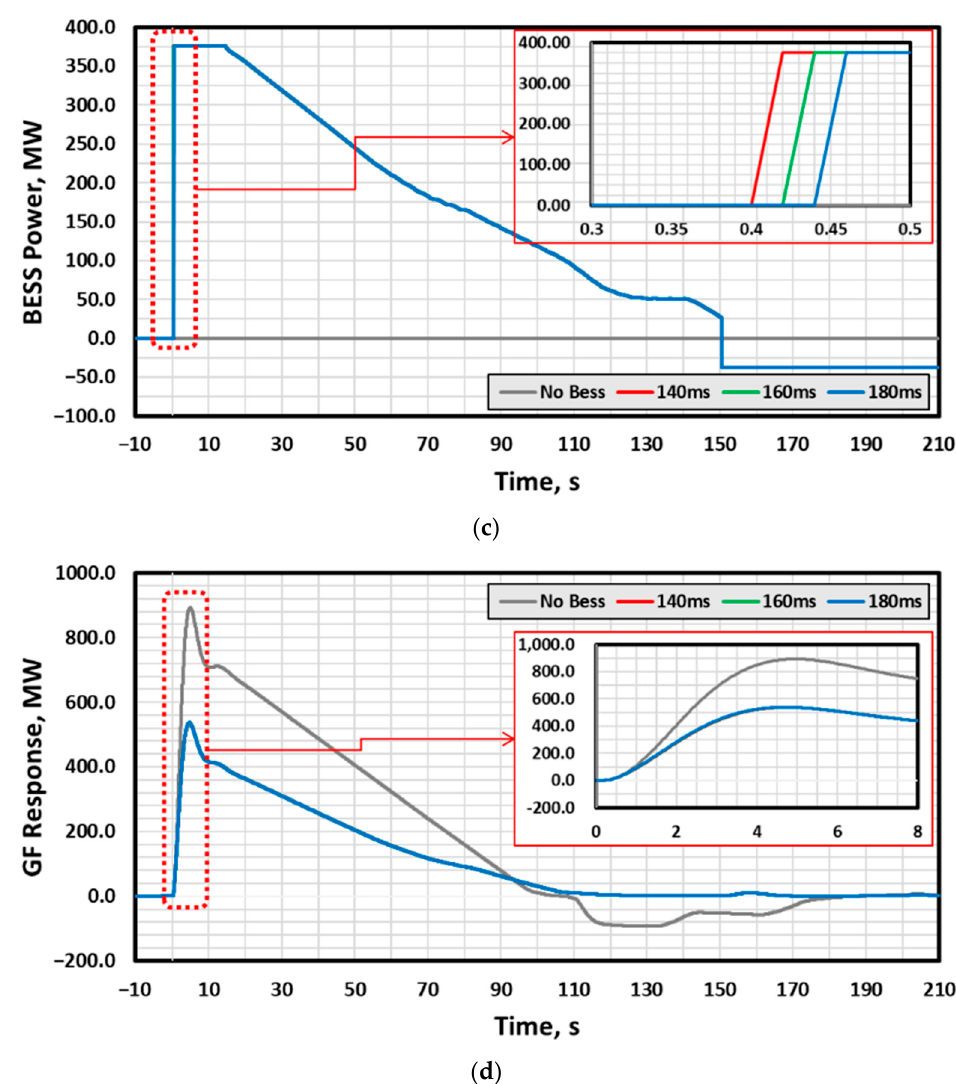
Figure 9. Result of frequency transient state simulation by case study; ( a ) Frequency; ( b ) RoCoF; ( c ) BESS Power; ( d ) GF response. Table 3. Summary of simulation results from the several case studies.